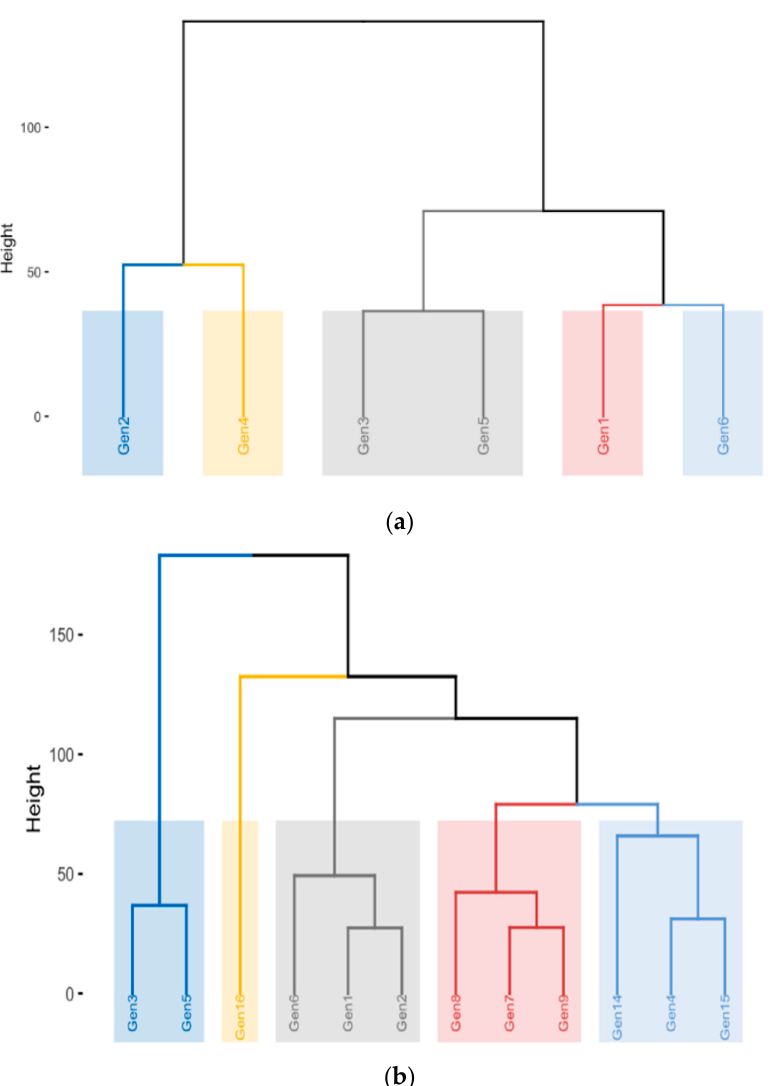
Figure 4. Hierarchical cluster analysis of yellow pitahaya genotypes: ( a ) open-field system and ( b ) system under cover.